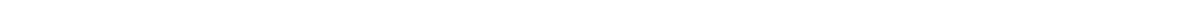
Fig. 4 Characterization of PDX1 + spermatogonia. a Representative whole-mount IF of WT (top 3 rows, n = 3 mice), Oct4-GFP and Pdx1 GFP adult tubules ( n = 2 mice per genotype). Antibodies to PDX1 and GFR α 1 are goat polyclonals and distinguished by nuclear vs . cell surface staining respectively. Scale